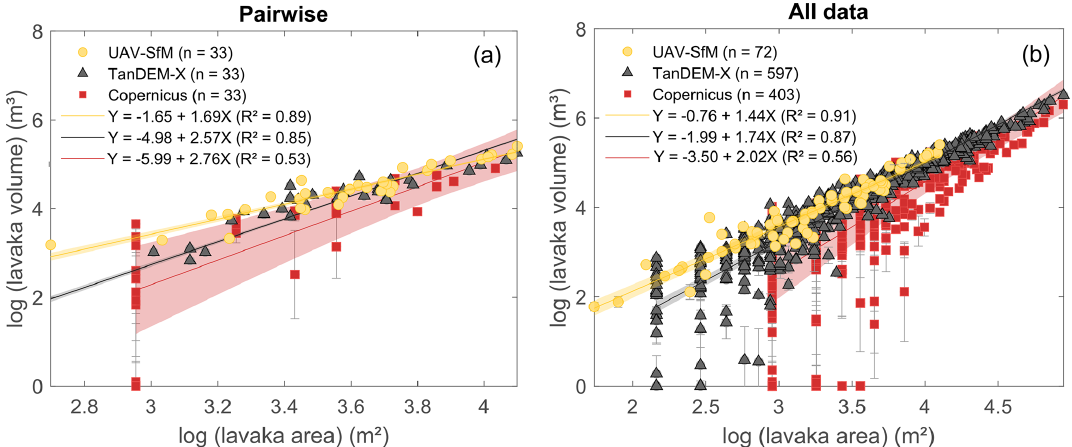
Figure 4. Area–volume relationships. Fitted linear area–volume relationships between the log-transformed lavaka areas and volumes for (a) the pairwise dataset and (b) the full datasets containing all lavaka volumes for all three DEMs. Grey error bars are the standard deviations of the mean calculated volumes representing the total uncertainty (interpolation and relative DEM uncertainty). Shaded bands indicate the 95% confidence intervals of the fitted relationships where the volumetric uncertainties are propagated through Monte Carlo